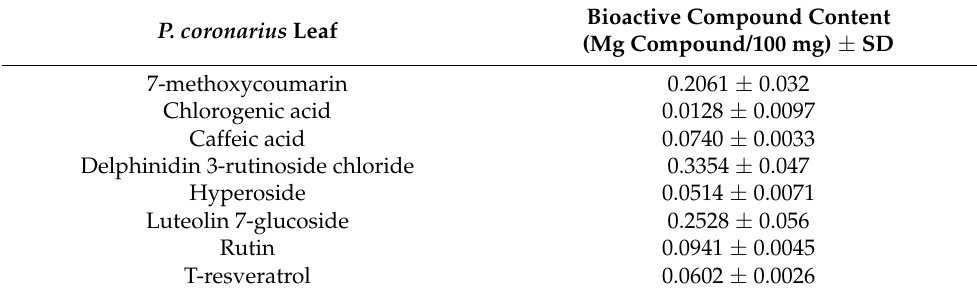
Table 1. Bioactive-compound content of P. coronarius leaves.